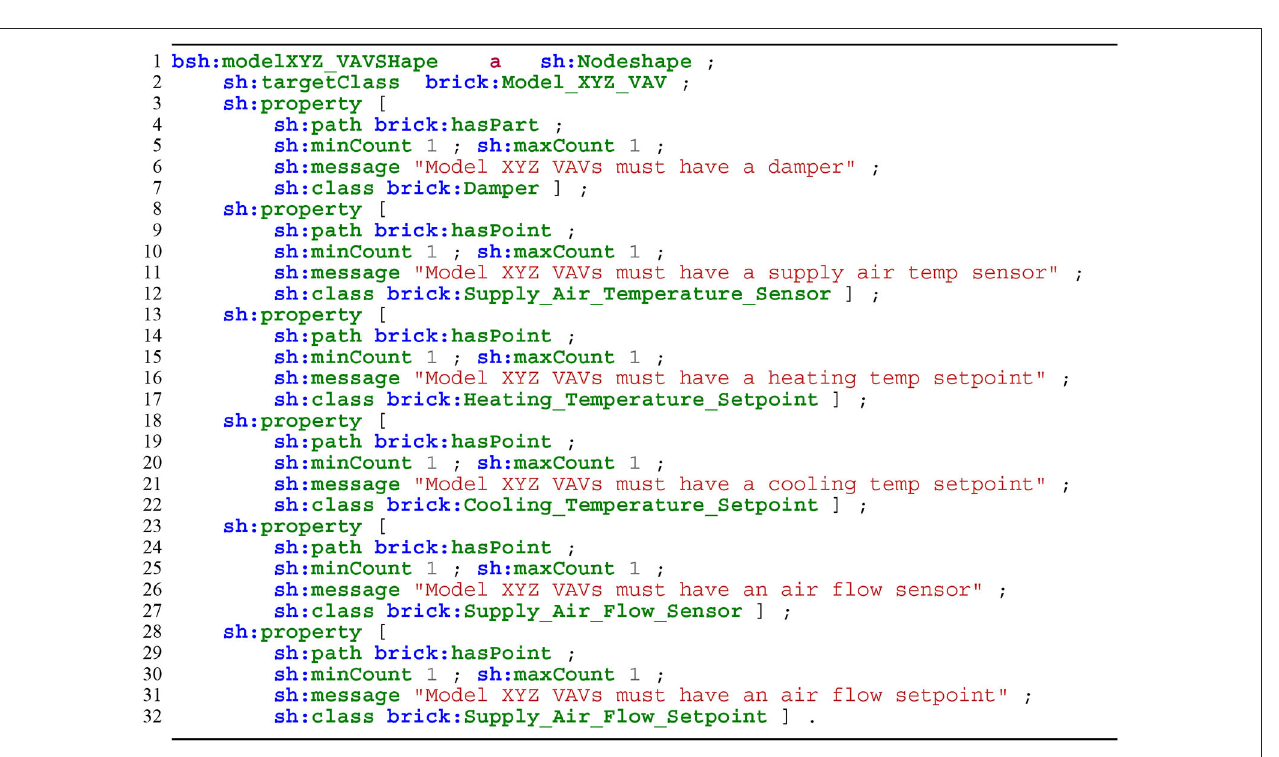
parlance. Line 4 indicates that the focus node’s class should be brick:Point